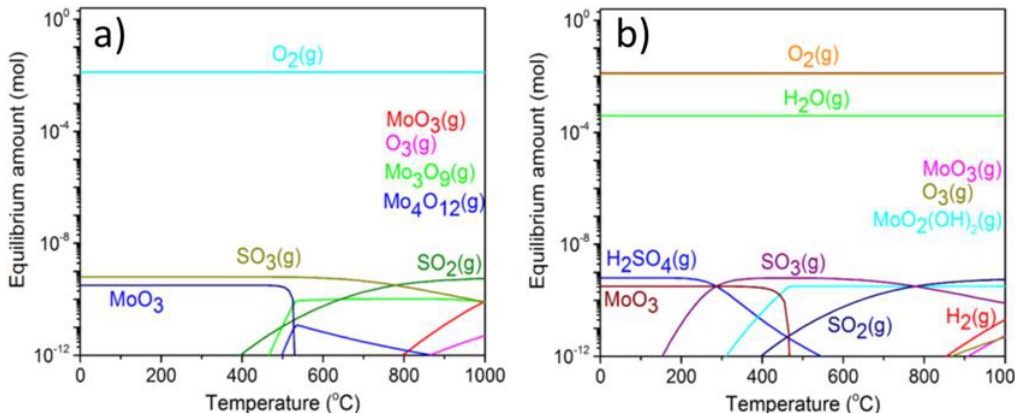
Figure 3. Thermodynamic calculations by Walter et al. showing thermal oxidation products for a fixed volume of the MoS 2 crystal placed within a closed container at partial pressure of oxygen, similar to air, ( a ) and with water vapors ( b ). Reprinted from Reference [36], with permission. Copyright 2017, American Vacuum